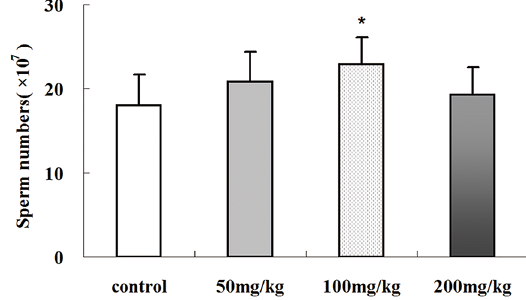
Figure 4. Epididymal sperm counts in SD rats treated with different doses of icariin. Values are the mean ± SD of 10 rats. * p< 0.01 vs. control group.